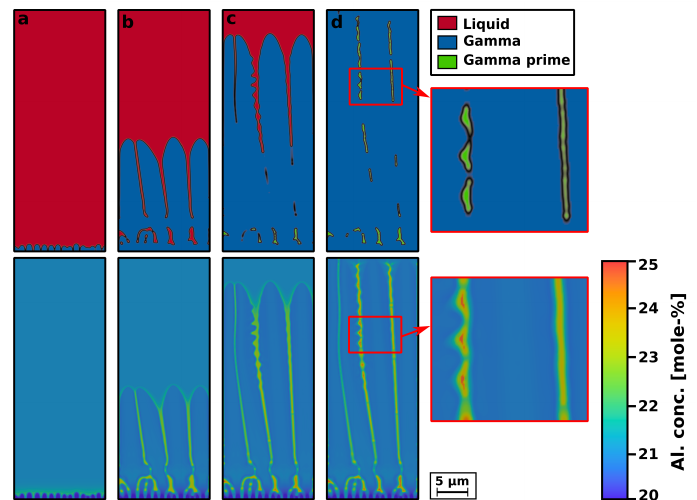
Figure 3. Microstructure evolution and the corresponding Al concentration distribution during solidification in context of the selective electron beam melting process for different time steps ( a = 0.0008 s, b = 0.0018 s, c = 0.0026 s, d = 0.09 s); on the right hand side is a magnification of the primary γ ’-particles.